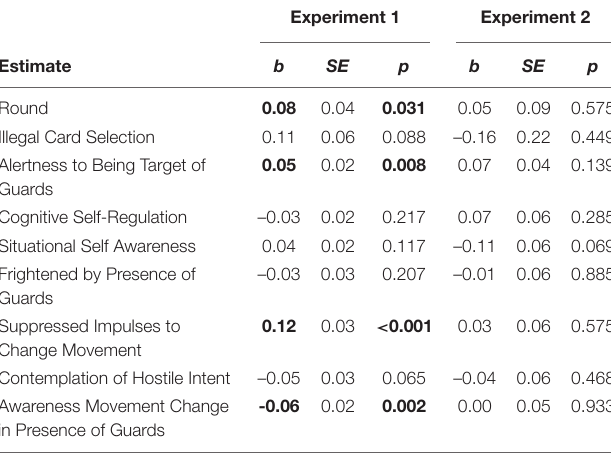
TABLE 2 | Regression beta, SE, and P -values for speed as dependent variable.